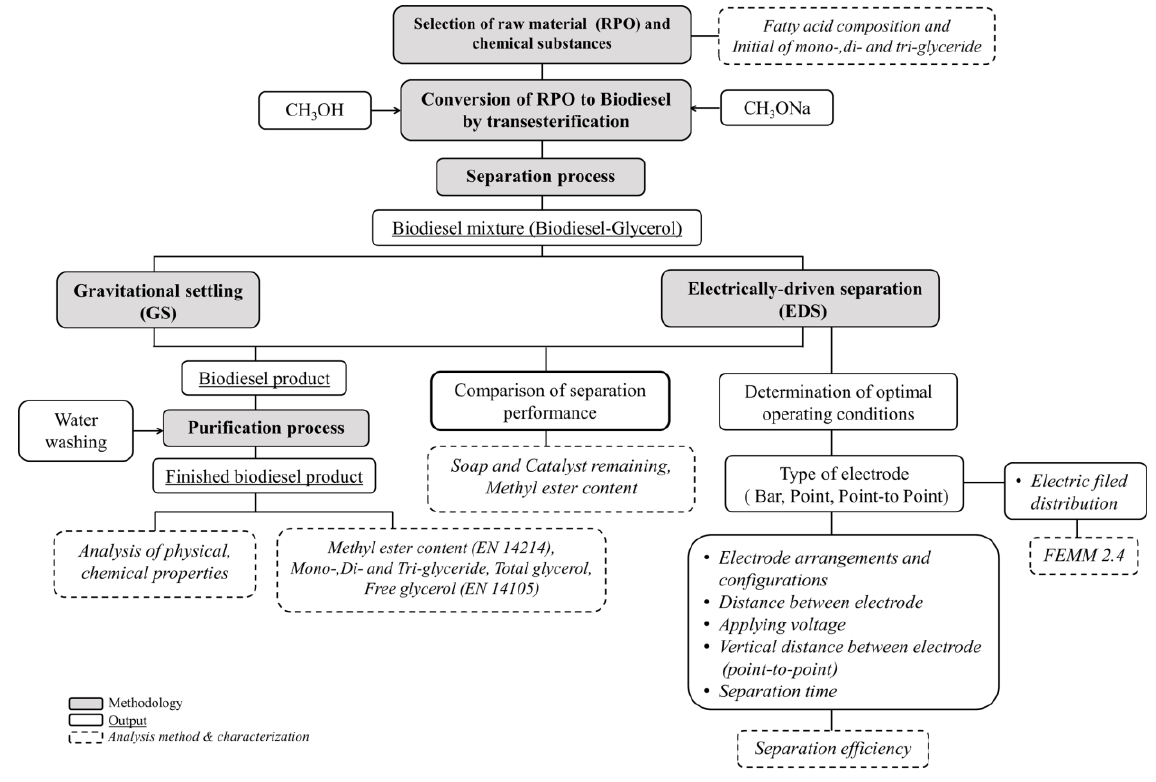
Figure 5. Flow chart of research methodology activities.